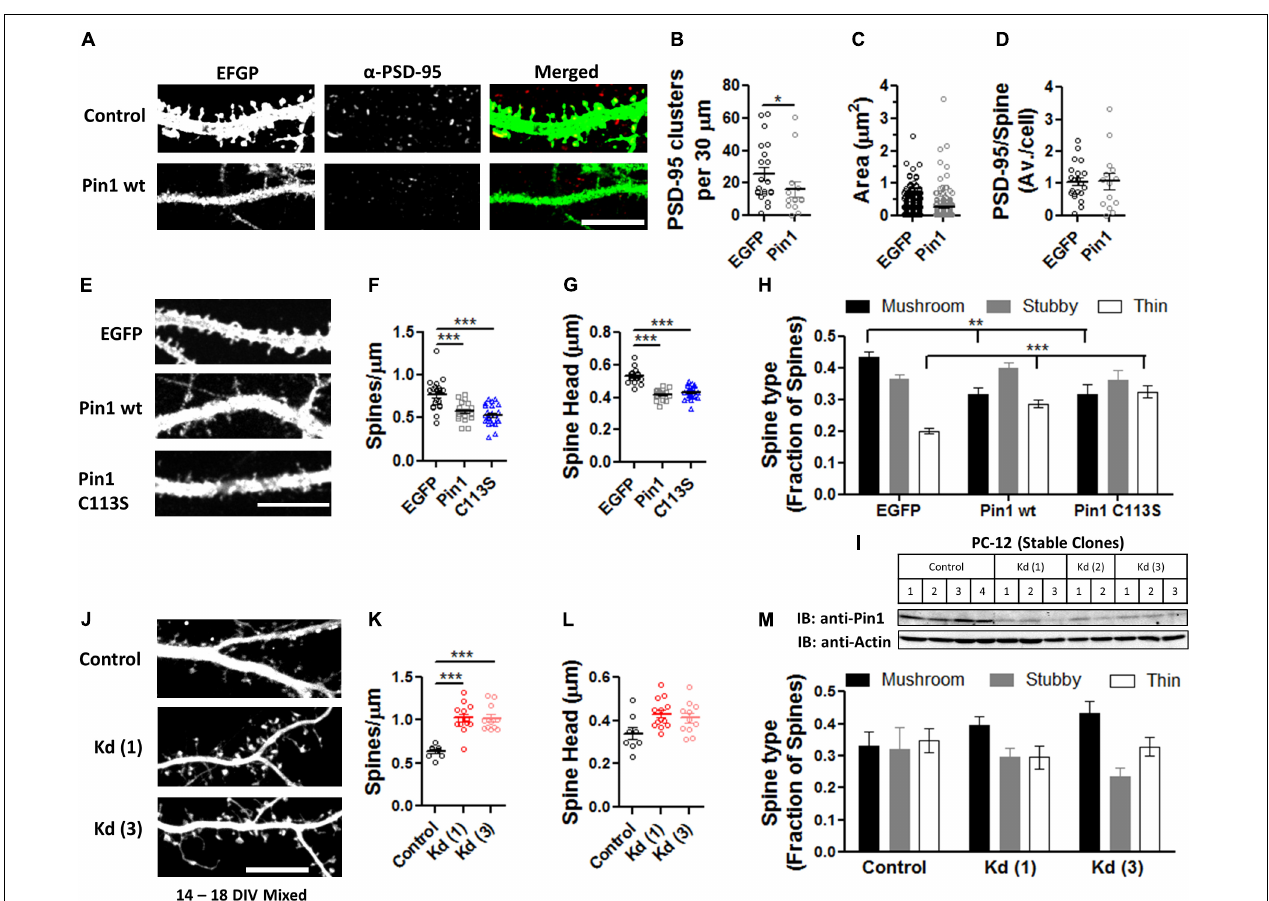
FIGURE 2 | Pin1 regulates excitatory spines and PSD-95 protein levels. (A) Confocal images of hippocampal cultured neurons expressing EGFP and Pin1 IRES2 EGFP. The signal for EGFP, PSD-95, and overlay are shown. Middle panel shows the area analyzed. (B) Pin1 overexpression decreases the number of post-synaptic PSD-95 clusters. Number of clusters per 30 µ m for EGFP 25.81 ± 4.06, n = 21; Pin1 15.79 ± 4.76, n = 14, Mann–Whitney test, p = 0.03. (C) Pin1 overexpression does not alter the size of post-synaptic PSD-95 punctate. EGFP 0.21 ± 0.010, n = 542; Pin1 0.24 ± 0.025, n = 221, Mann–Whitney test, p = 0.93. (D) Pin1 overexpression does not changes the number of the remaining spines with PSD-95 labeling. EGFP 1.06 ± 0.13; Pin1 1.07 ± 0.25, Mann–Whitney test, p = 0.66. For all scale bar 10 µ m. (E) Confocal images of hippocampal cultured neurons at 14 days in vitro (range 12–14 DIV) expressing EGFP (control) or Pin1 or the C113S isomerase dead mutant. (F) Pin1 overexpression decreases the number of post-synaptic spines. EGFP 0.77 ± 0.04, n = 20; Pin1 0.57 ± 0.02, n = 20; C113S 0.53 ± 0.02, n = 25. One-way ANOVA F (2,62) = 18.98, p = 0.0001. (G) Pin1 overexpression reduces the size of post-synaptic dendritic spines. EGFP 0.53 ± 0.01, n = 20; Pin1 0.41 ± 0.01, n = 20; C113S 0.43 ± 0.01, n = 25, Kruskal–Wallis chi-square = 39.51, df = 2, p < 0.0001 (H) Pin1 overexpression alters the diversity of post-synaptic spines. Control mushroom 0.44 ± 0.01, stubby 0.36 ± 0.02, thin 0.20 ± 0.01, n = 20; Pin1 mushroom 0.31 ± 0.02, stubby 0.40 ± 0.02, thin 0.29 ± 0.01, n = 20; C113S mushroom 0.32 ± 0.03, stubby 0.36 ± 0.03, thin 0.32 ± 0.02, n = 25. Two-way ANOVA overexpression F (2,186) < 0.001, p = 0.99, spine type F (2,186) = 18.33, p < 0.0001, the interaction was significant, F (4,186) = 9.242, p < 0.0001, ** p = 0.013. (I) Western blots showing the level of knockdown of Pin1 protein from PC12 cell lysates stably expressing control shRNA or the various shRNA constructs (named Kd 1-3), a quantification of the knockdown of Pin1 from the western blot shown in (I), One-way ANOVA with Turkey’s multiple comparison test, F (3,8) = 23.06, p = 0.0003. (J) Confocal images of mixed-typed hippocampal cultured neurons at 18 days in vitro (range 14–18 DIV) expressing Turbo-mRFP with scramble shRNA or two shRNAs against the Pin1 mRNA. (K) Pin1 knockdown increases the number of post-synaptic spines. Control 0.63 ± 0.02, n = 8; Kd (1) 1.02 ± 0.05, n = 13; Kd (3) 1.02 ± 0.05, n = 11. Four coverslips/three different dissections. One-way ANOVA F (2, 29) = 22.32, p < 0.0001. (L) Pin1 knockdown slightly increases the size of post-synaptic dendritic spines. Control 0.34 ± 0.03, n = 8; Kd (1) 0.43 ± 0.02, n = 13; Kd (3) 0.41 ± 0.02, n = 11. One-way ANOVA F (2,29) = 3.995, p = 0.0293. (M) Pin1 knockdown triggers a slight increase in mushroom spines. control mushroom 0.33 ± 0.04, stubby 0.32 ± 0.05, thin 0.35 ± 0.04; Kd (1) mushroom 0.39 ± 0.03, stubby 0.30 ± 0.03, thin 0.3 ± 0.04; Kd (3) mushroom 0.43 ± 0.04, stubby 0.24 ± 0.03, thin 0.33 ± 0.03. Two-way ANOVA overexpression F (2,87) = 0.01, p = 0.99, spine type F (2,87) = 5.92, p = 0.0039, the interaction , F (4,87) = 1.93, p = 0.1124. *** p ≤ 0.001.